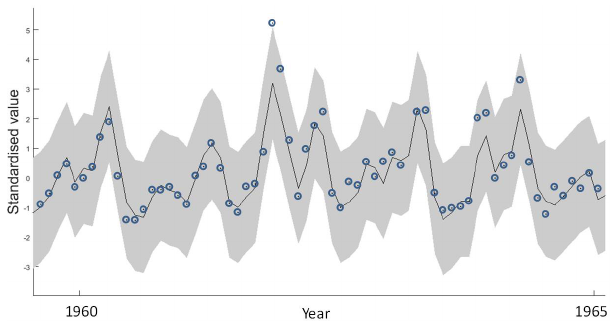
Figure 4. Example of standardised net inflow estimates from a transfer function model for Lake Victoria net inflows for part of the validation period, with fixed parameter values; observations appear as dots and the shading corresponds to twice the model standard error, which is approximately equivalent to the 95% confidence in- terval. Note that, due to sampling uncertainties, the number of val- ues within or outside the intervals varies depends on the period(s)